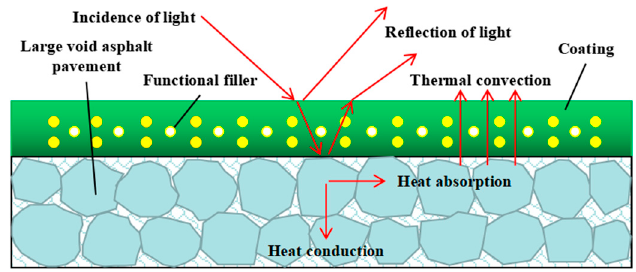
Figure 2. Cooling mechanism of large void coated pavement.